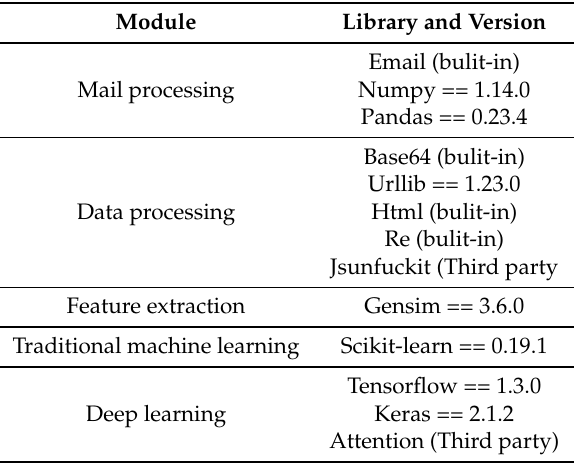
Table 6. Experiment